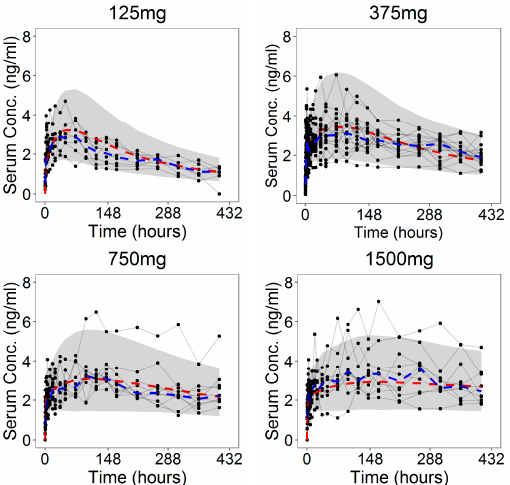
Figure 10. Visual predictive check (VPC) plots (500 individuals for dose level) for the progesterone serum concentration profiles stratified on the dose level: The 90% confidence interval (grey area) is shown together with the observed data (black dots); dashed lines represent the theoretical (red) and experimental (blue) median.